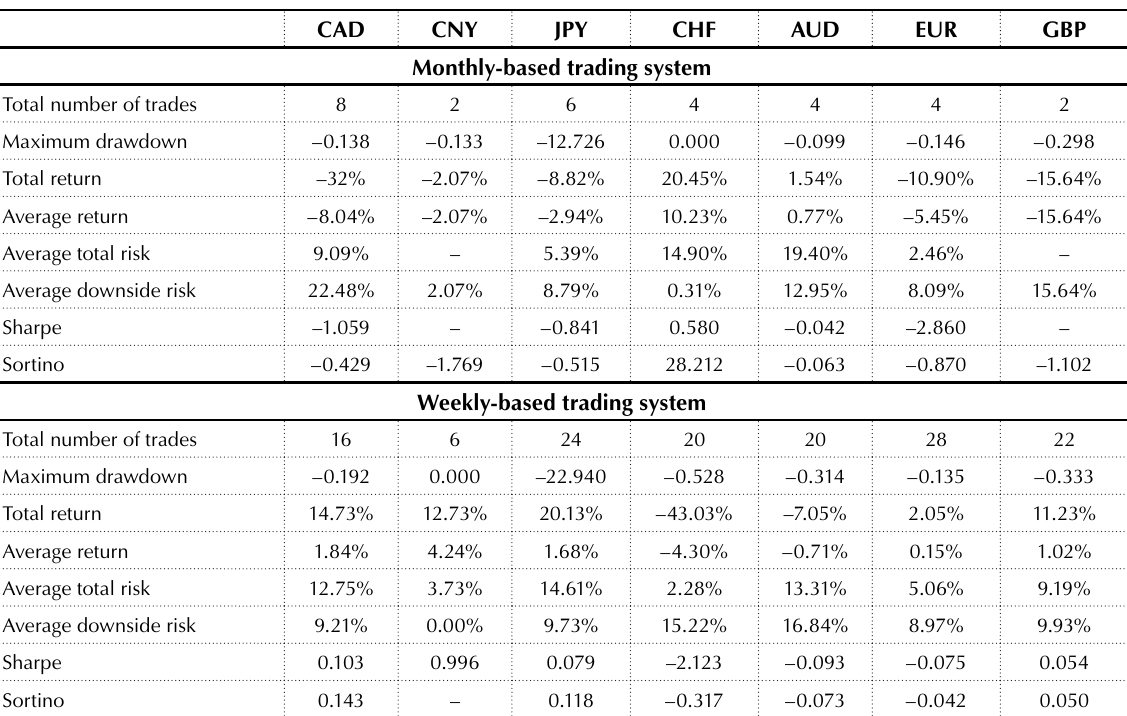
Table 1. Performance of trading strategy